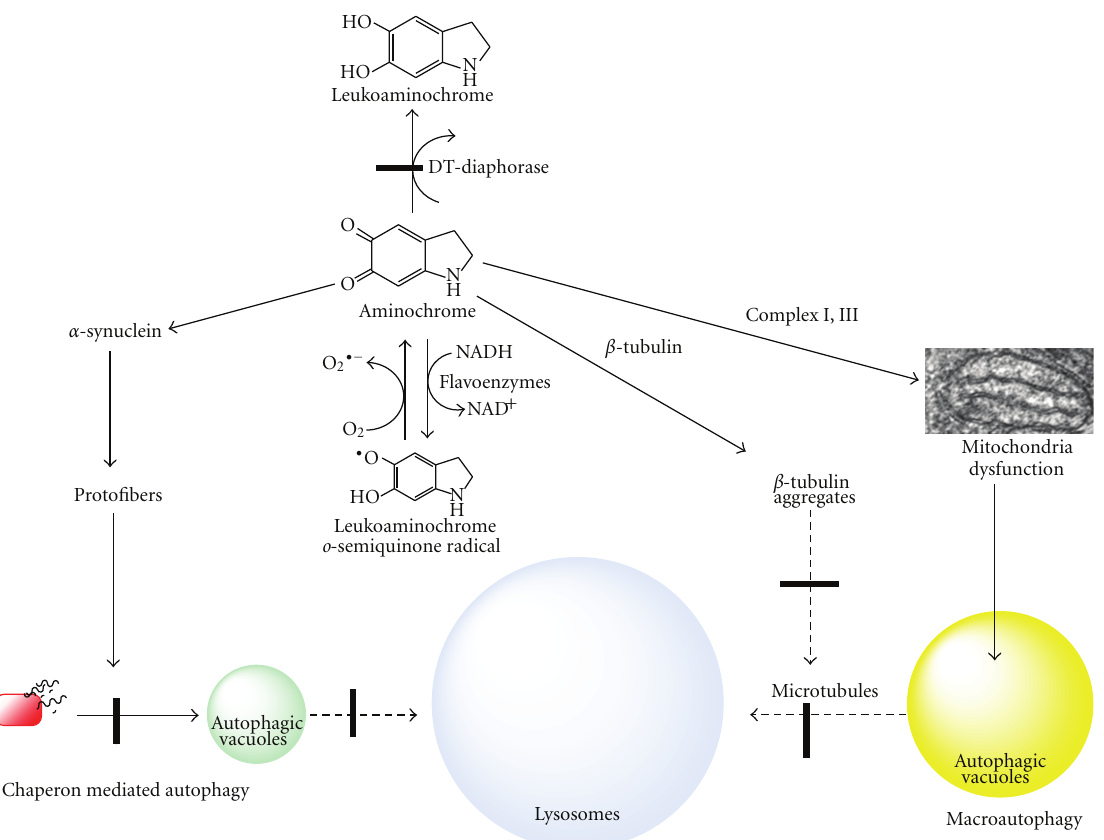
Figure 10: Possible role of aminochrome in autophagy. Aminochrome induces the dysfunction of autophagy by forming adducts with the following: (i) alpha synuclein, which inactivates chaperone-mediated autophagy; and (ii) α - and β -tubulin, inducing the aggregation of microtubules, which are essential for the fusion of autophagy vacuoles with